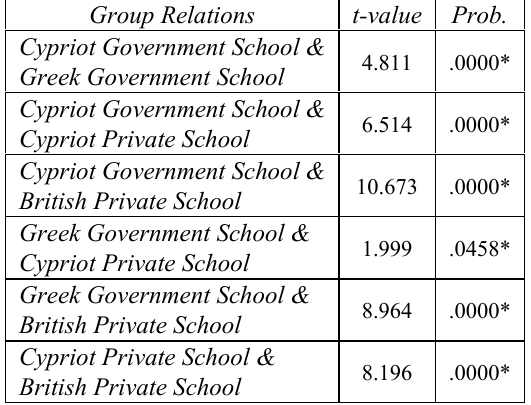
Table 3: Two-sample t-test between the groups